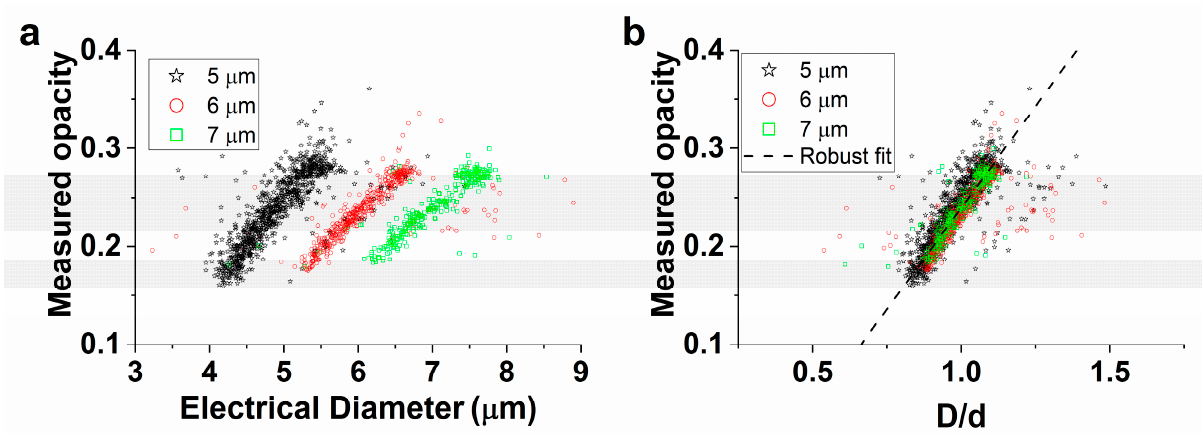
Figure 4. ( a ) Measured opacity as a function of the electrical diameter of 5, 6, and 7 µ m monodisperse beads. ( b ) Measured opacity versus the normalized electrical diameter D/d for the same populations of beads as in ( a ). A robust fit was used to determine the fitting parameters c 1 and c 2 in Equation (6) for each set of beads. The displayed fit is the average of these three sets. The electrical diameter was based on the 0.5 MHz impedance signal and the opacity was expressed as Δ | Z | 20MHz / Δ | Z | 0 . 5MHz .